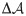
Deviation ΔA (a,b), ΔAPA (c,d) and ΔAPD (e,f) as a function of gCa/γCa for fixed gNa = γNa = 7.8 nS/pF (a,c,e) and as a function of gNa/γNa for fixed gCa = γCa = 0.0433 nS/pF (b,d,f).The assignment of the symbols in plot (f) is the same as in plot (e). The dashed line in each plot indicates deviations of 10%.